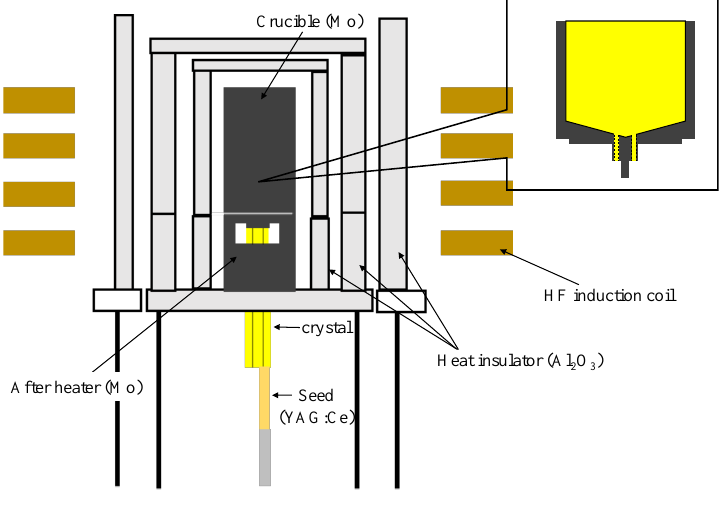
Figure 2. Schematic diagram of crystal-growth